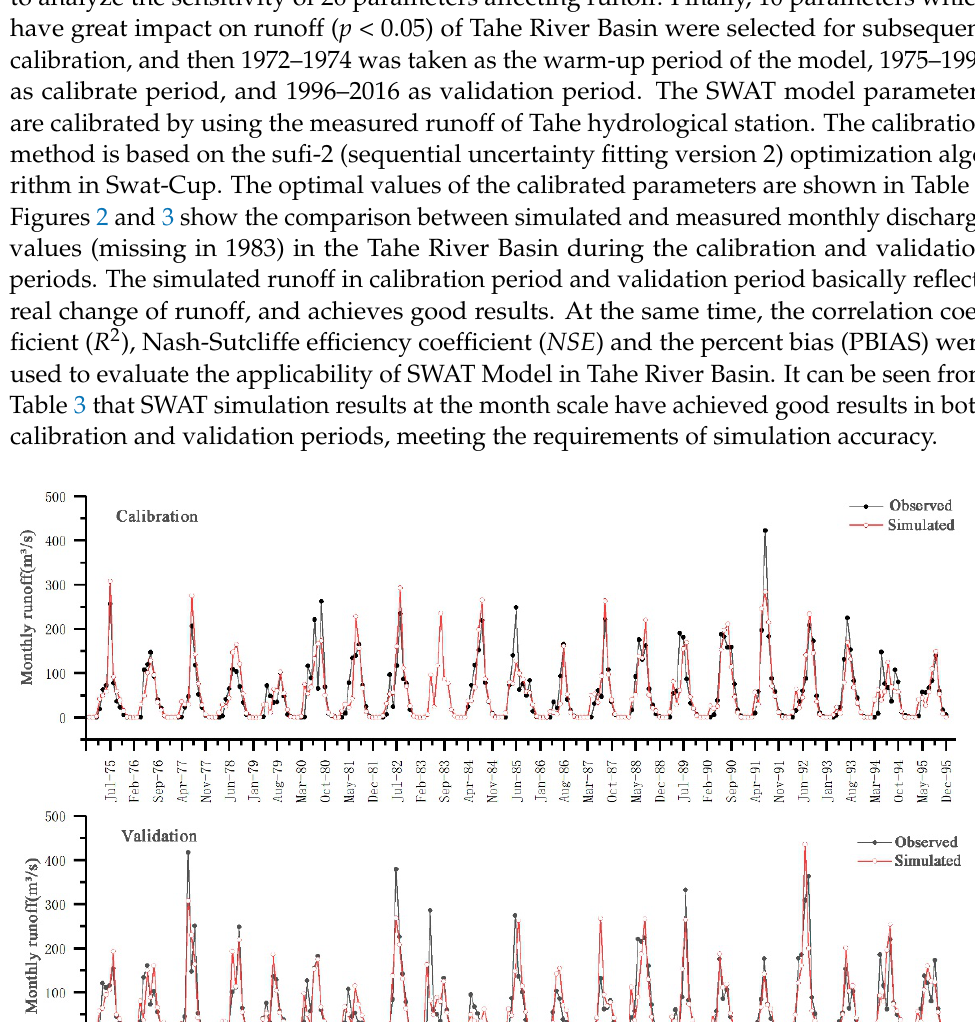
Table 3. Evaluation of monthly runoff simulation results of SWAT Model in Tahe River Basin.